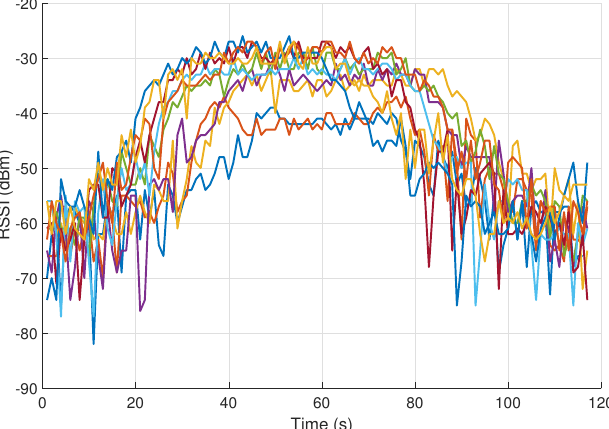
Figure 3. RSSI signals in dBm measurements associated with mouth touching (10 different signals representing the same hand movement kind).